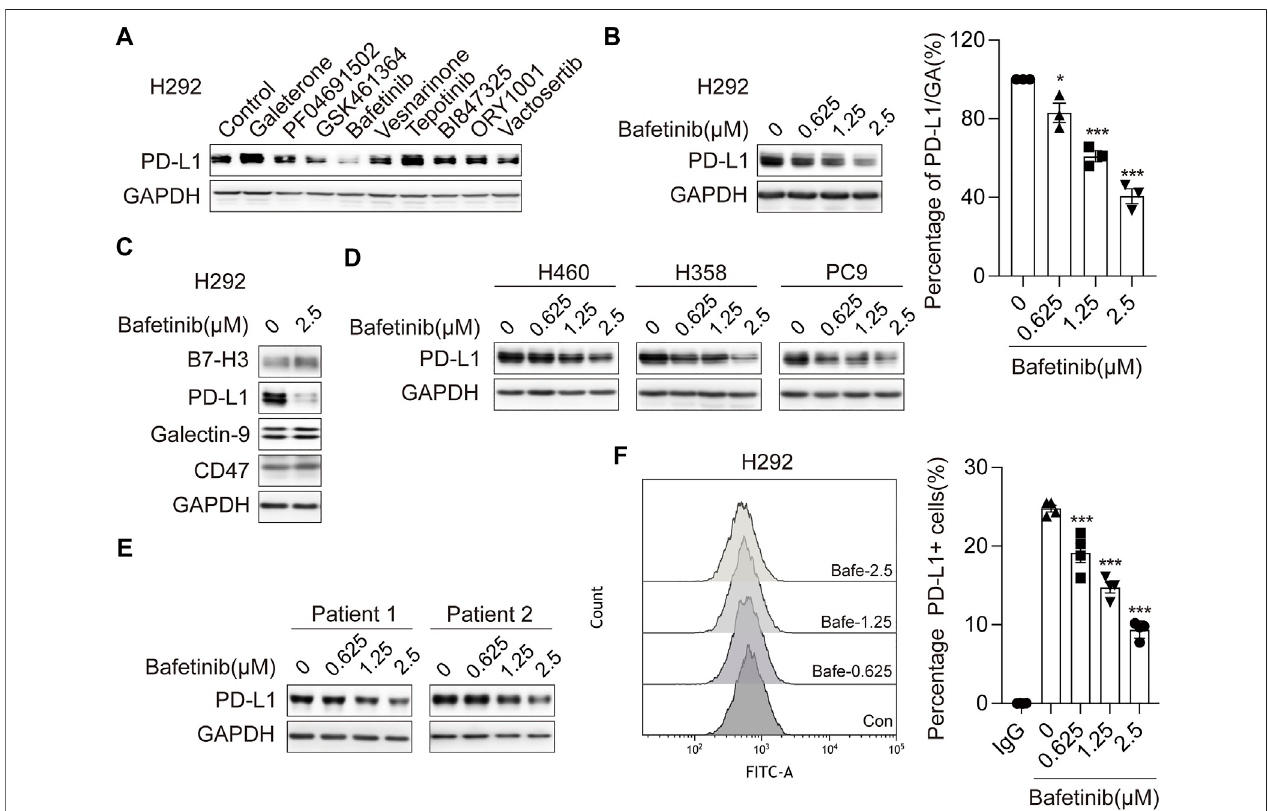
FIGURE 1 | Bafetinib inhibits the expression of PD-L1 in lung cancer. (A) Screening on H292 cells treated with different small molecule drugs (10 μ M) for 24 h. (B) The expression of PD-L1 protein was measured by Western blot in H292 cells, which were treated with Bafetinib (0.625, 1.25, and 2.5 μ M) for 24 h. The relative protein level of PD-L1 in H292 was quantitatively analyzed on the right. (C) Expression of B7-H3, Galectin-9, PD-L1, and CD47 was measured by Western blot in H292 cells when treated with Bafetinib (2.5 μ M) for 24 h (D, E) The expression of PD-L1 protein was measured by Western blot in H460, H358, PC9 cells, and primary lung cancer when treated with Bafetinib (0.625, 1.25, and 2.5 μ M) for 24 h. (F) Surface PD-L1 expression on H292 treated with Bafetinib (0.625, 1.25, and 2.5 μ M) was determinedby fl